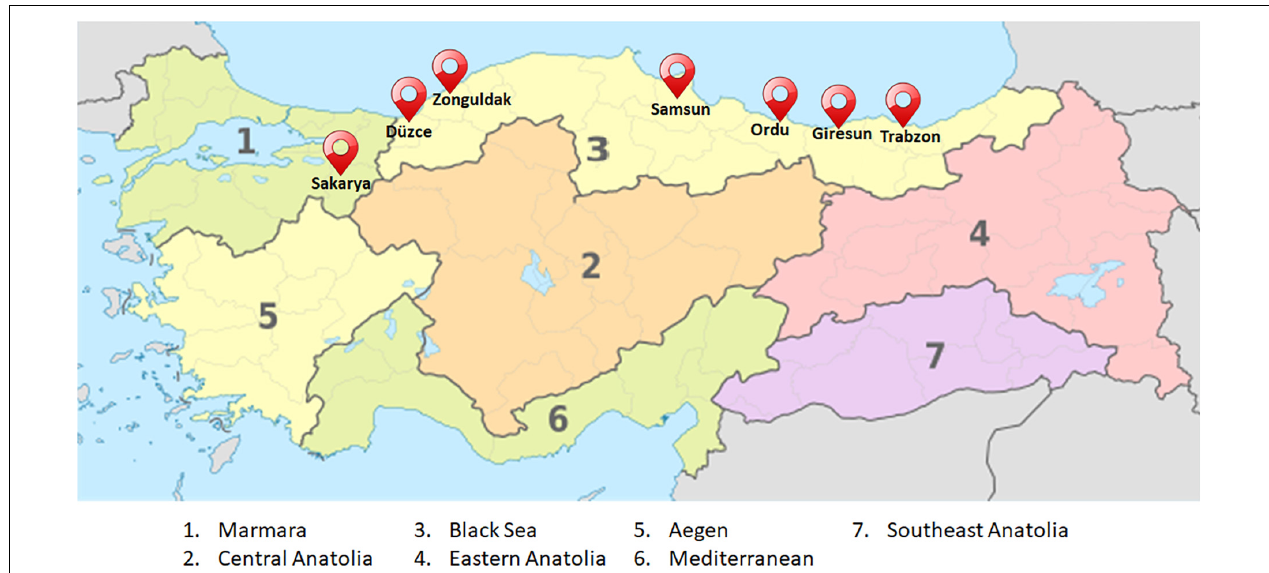
FIGURE 1 | Distribution of the seven sampled hazelnut orchards located in different Turkish provinces (https://upload.wikimedia.org/wikipedia/commons/f/f9/Turkey_ %28regions%29%2C_administrative_divisions_-_Nmbrs_-_colored.svg adapted).